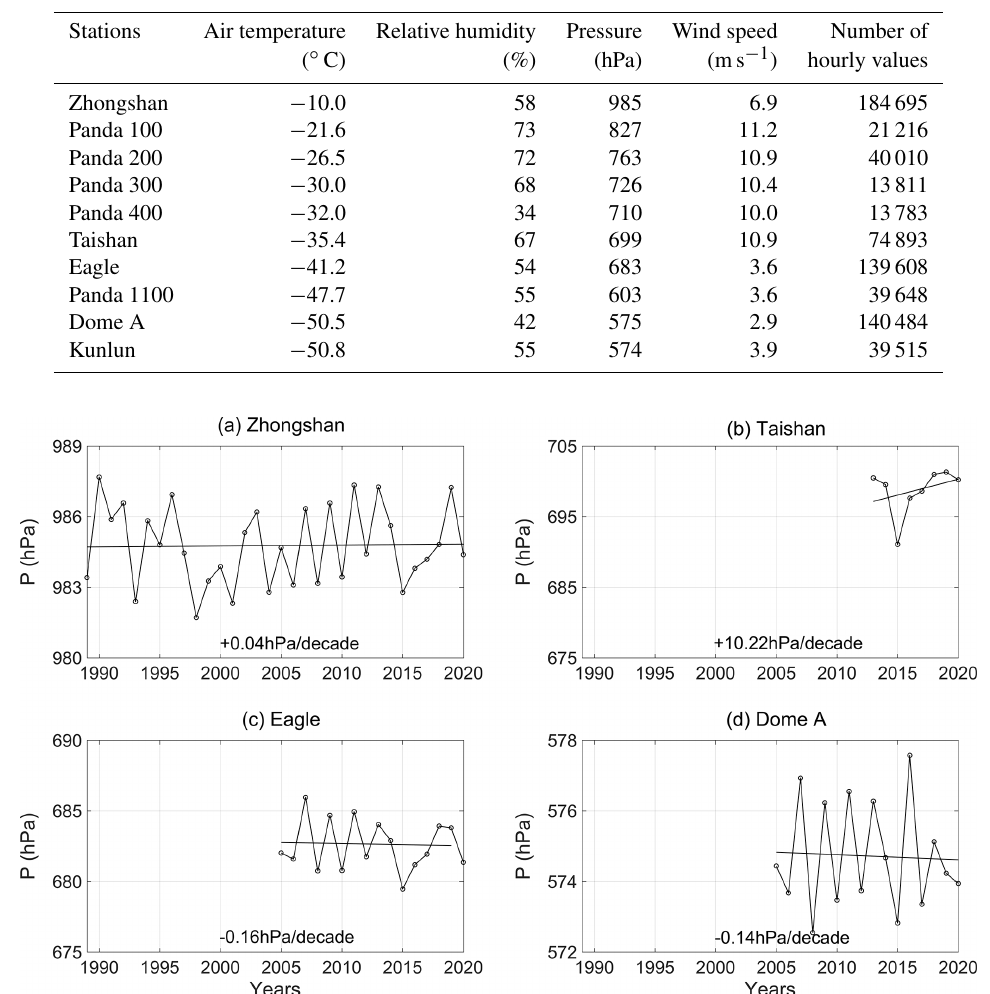
Figure 9. Diurnal variation in wind speed of the PANDA AWS network. The calculation periods for these sites are the same as for Fig. 1; Zhongshan is calculated during